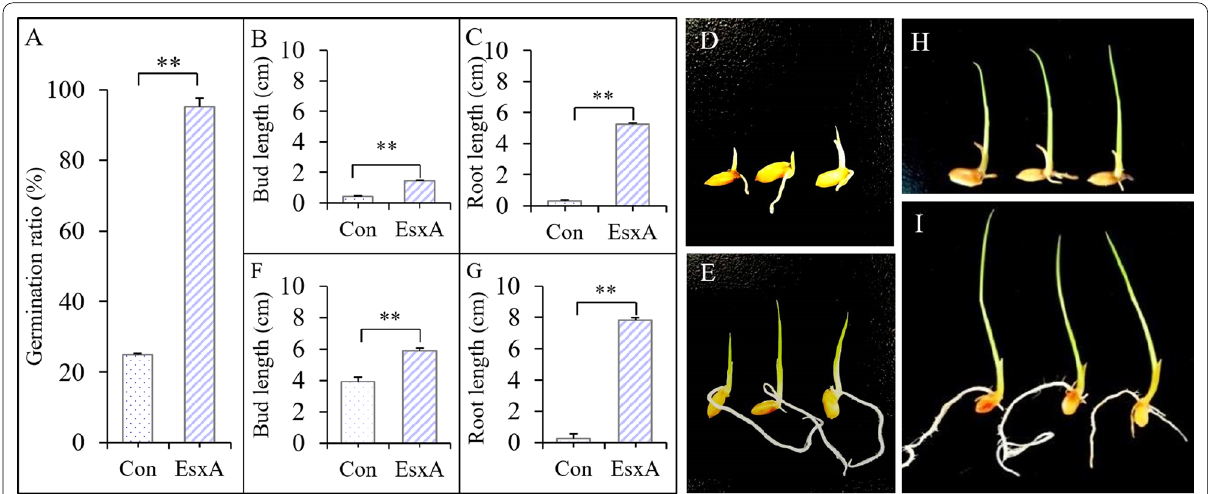
Fig. 1 Effects of protein elicitor EsxA on the germination and growth of rice under seedling blight ( Fusarium oxysporum ) stress (seed-dipping treatment). Bar diagrams A , B , C , D and E present the results at 4 days after rice was challenged with Fusarium oxysporum ; F , G , H and I represent 8 days after rice was challenged with F. oxysporum , respectively, with “Con” representing the control treatment (without EsxA) and “EsxA” representing the EsxA treatment (** P <